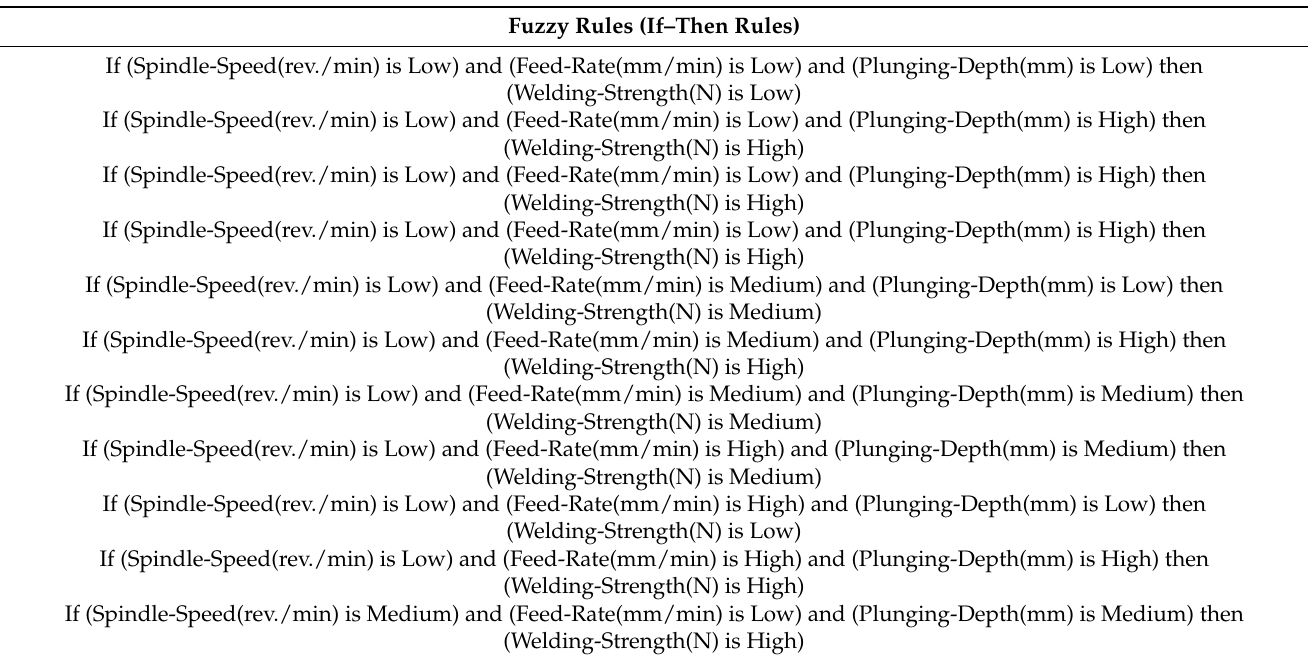
Table 8. FSSW strength fuzzy system’s If–Then rules.